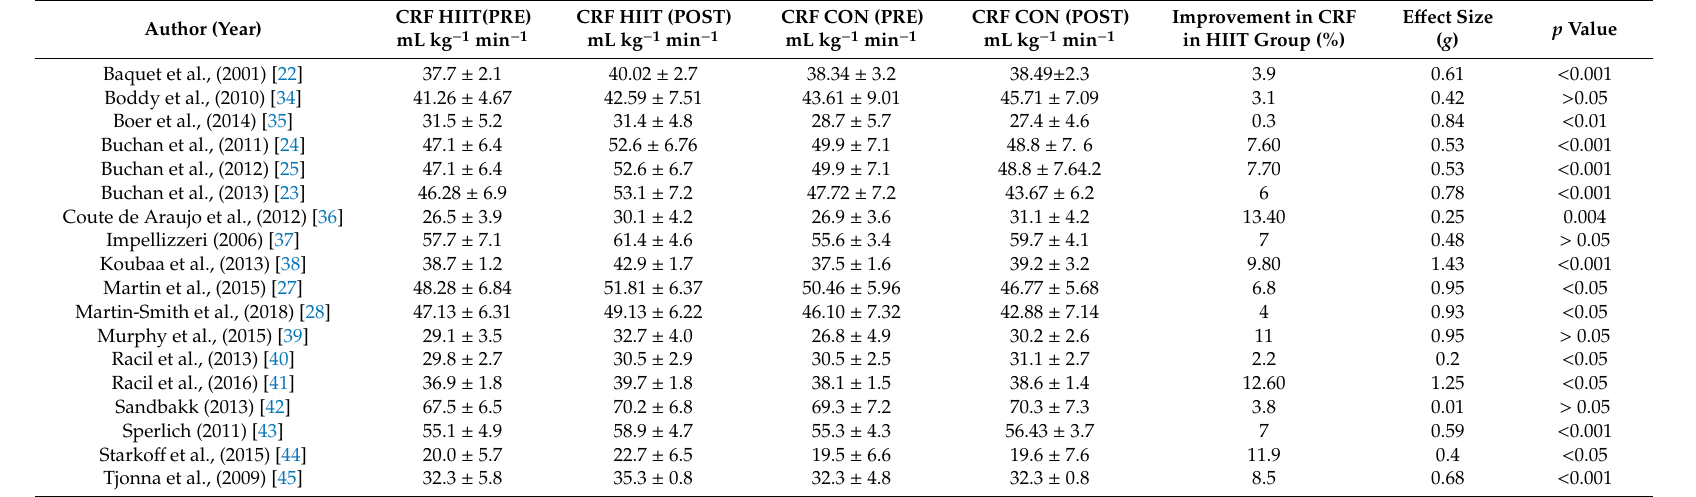
Table 3. Cardiorespiratory fitness (CRF) PRE and POST Values in HIIT and CON